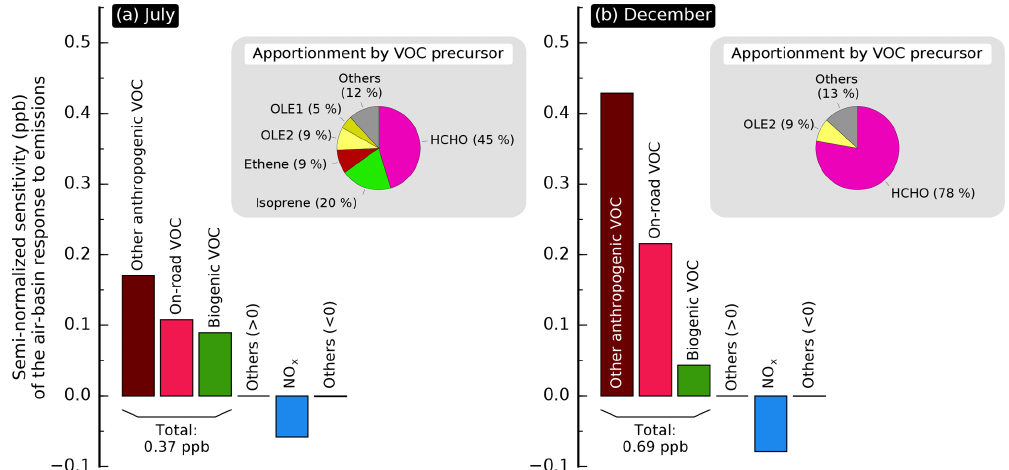
Figure 3. Semi-normalized sensitivity of the air-basin-wide population-weighted formaldehyde mixing ratio to emissions in (a) July and (b) December. An apportionment by precursor species of the sensitivity to overall VOC emissions is shown in the pie chart insets.